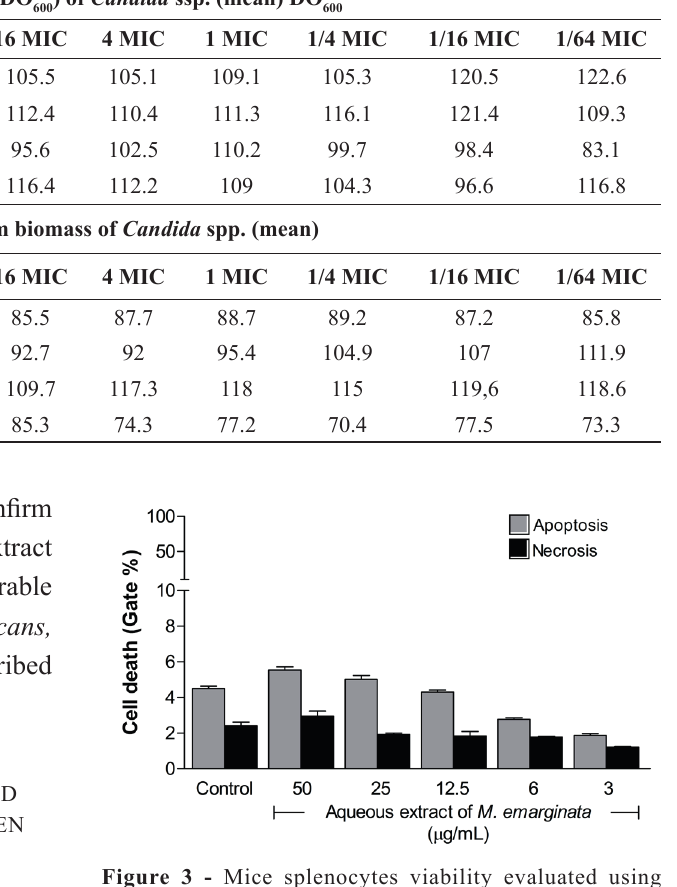
Results on the antibiofilm activity of Malpighia emarginata saline extract, in percentage, of Candida ssp. tested. Value% of growth (DO ) of Candida ssp. (mean) DO 600 600